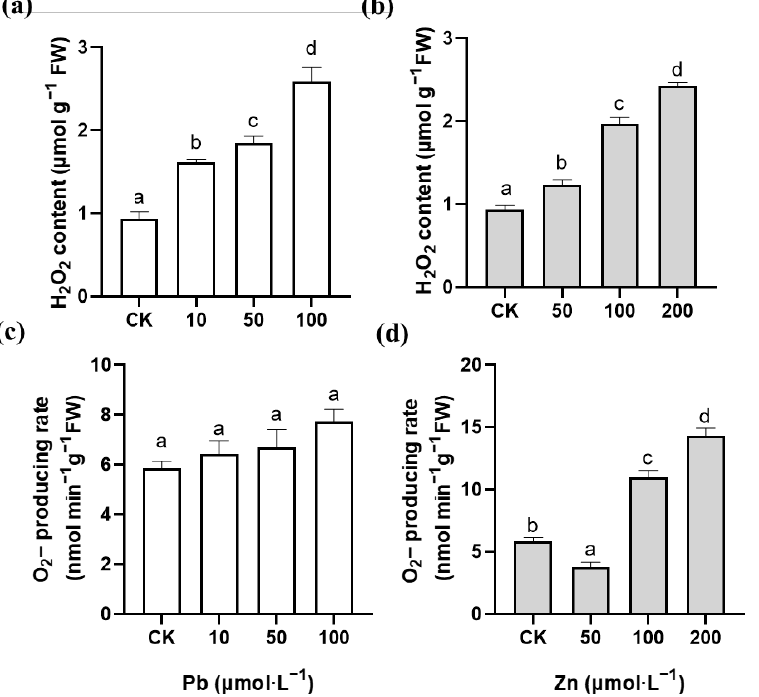
Figure 3. DAB and NBT staining of H 2 O 2 ( a , b ) and O 2 − ( c , d ) in roots of M. cordata grown hydropon- ically under control (CK) and varied concentrations of Pb and Zn for seven days . Bar, 1 mm. Staining experiments were repeated at least five times with similar results.